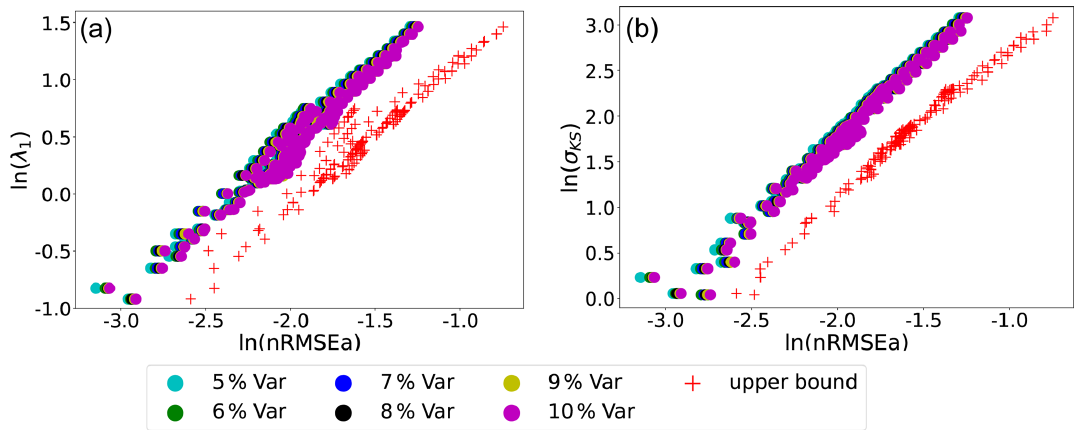
Figure 9. Scatter plots of σ KS (a) and λ 1 (b) against nRMSEa. The log–log scale is used on both axes. The different points refer to experiments with different observation error given in the legend and model parameter as in Figs. 3 and 5, excluding weakly unstable cases with σ KS < 1 and hence excluding cases where ln ( nRMSEa ) < − 4, similar to Fig.